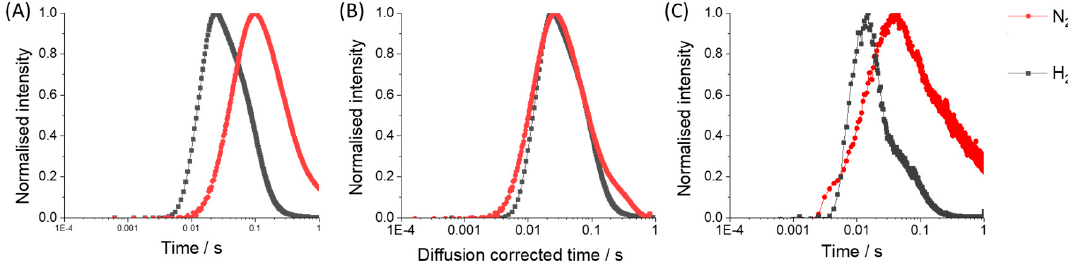
Figure 6. Transient product time-dependencies for H 2 and N 2 when NH 3 /Argon is pulsed over the Cobalt catalyst; height normalized for comparison, ( A ) experimentally observed exit flux, ( B ) N 2 flux was corrected uniformly to match the effective diffusivity of H 2 , ( C ) product rate calculated using the Y-Procedure.